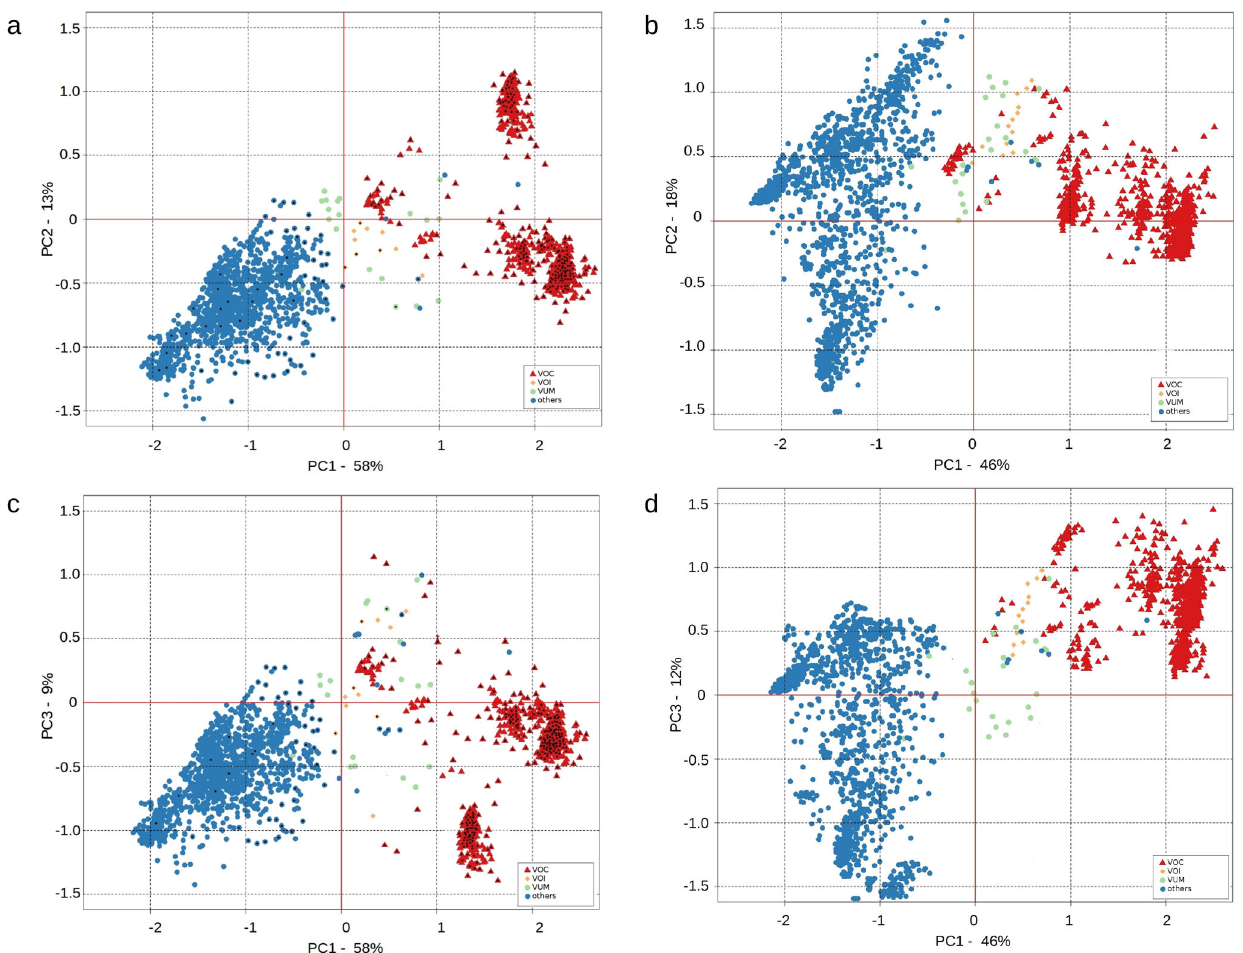
Fig. 4 PCA representation of 113 descriptive features for the 2607 Pango/Pango + lineages and the 1571 HGs. Distinct colors are used to represent VOC (red), VOI (yellow), VUM (green) and other variants (blue). a Pango/Pango + Lineages, PC1 and PC2. Pango + lineages are. b HGs, PC1 and PC2. c Pango/Pango + Lineages, PC1 and PC3. d HGs, PC1 and PC3. Pango + lineages are marked by an overlaid black dot. The 113 descriptive features are listed in Supplementary Data